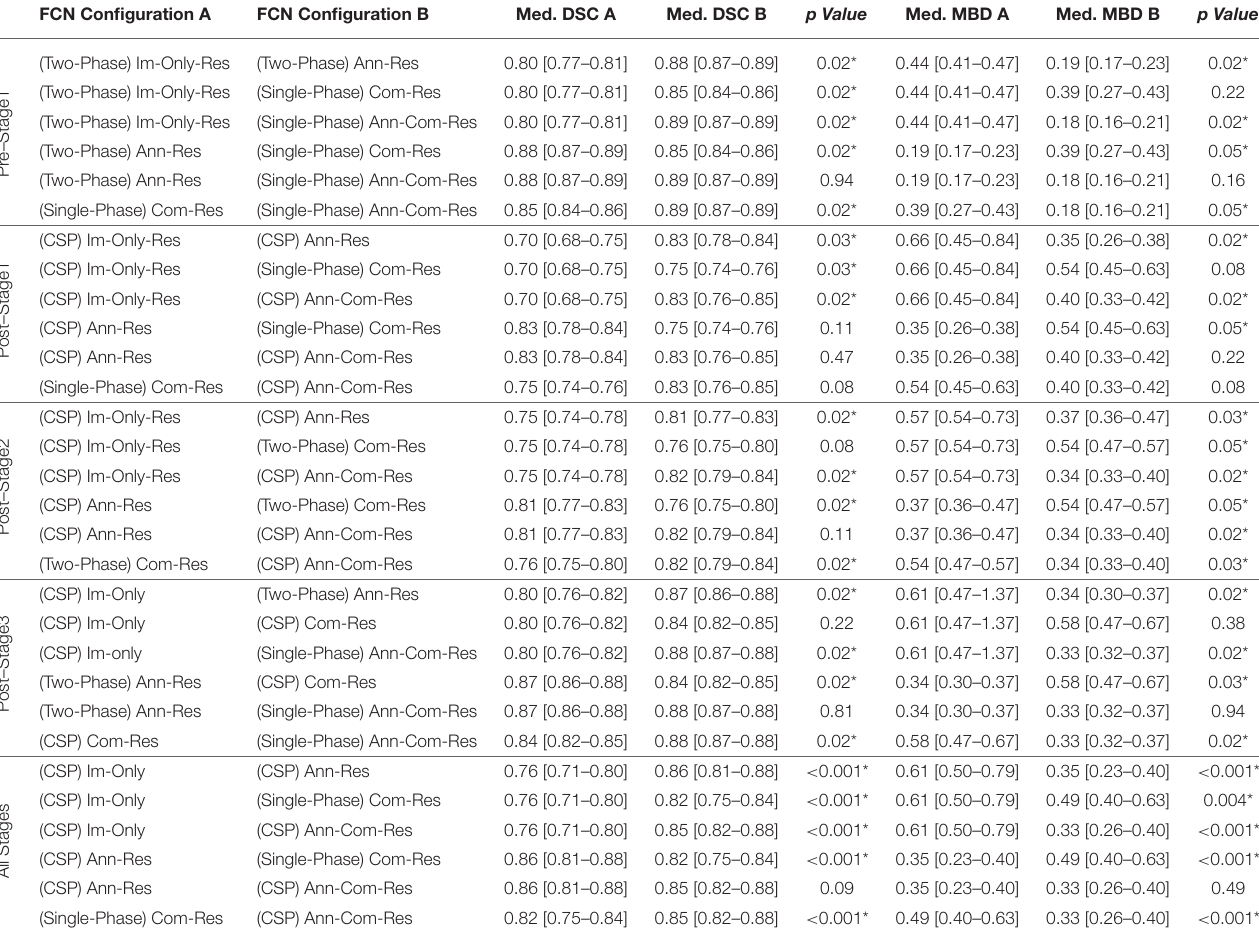
TABLE 6 | Median DSC and Median MBD of merged leaflets, and p values for two–sided non–parametric Wilcoxon signed–rank test at individual stages and all stages combined. FCN Configuration